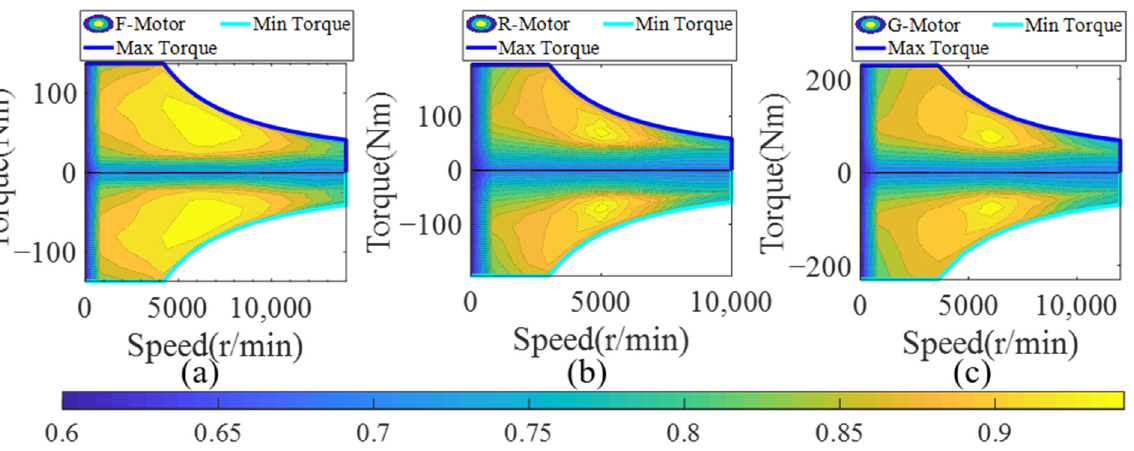
Figure 3. Efficiency maps of the front/rear motors and generator. ( a ) Front motor; ( b ) Rear motor; ( c ) Generator